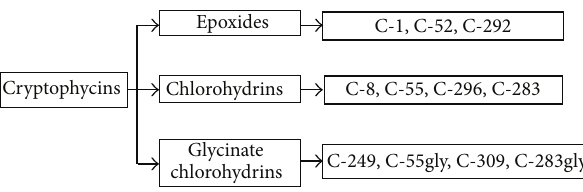
Figure 3: Classification of